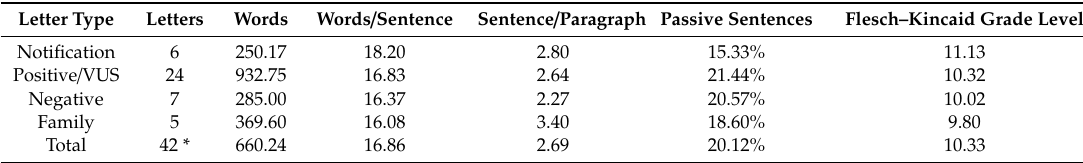
Table 4. Readability statistics by letter